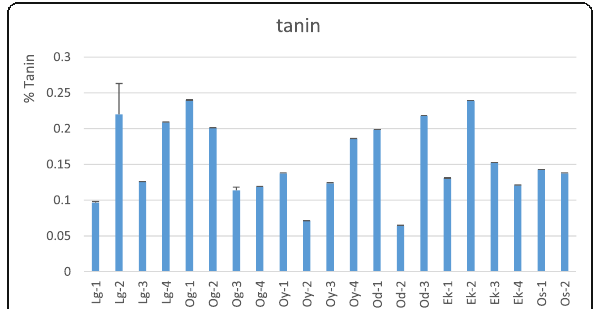
Fig. 4 Tannin content of Moringa oleifera leaf from the 21 locations. The results are mean of triplicates with the error bars (standard deviation). The chart shows significant between- and within-group differences in the tannin content of the samples from the locations